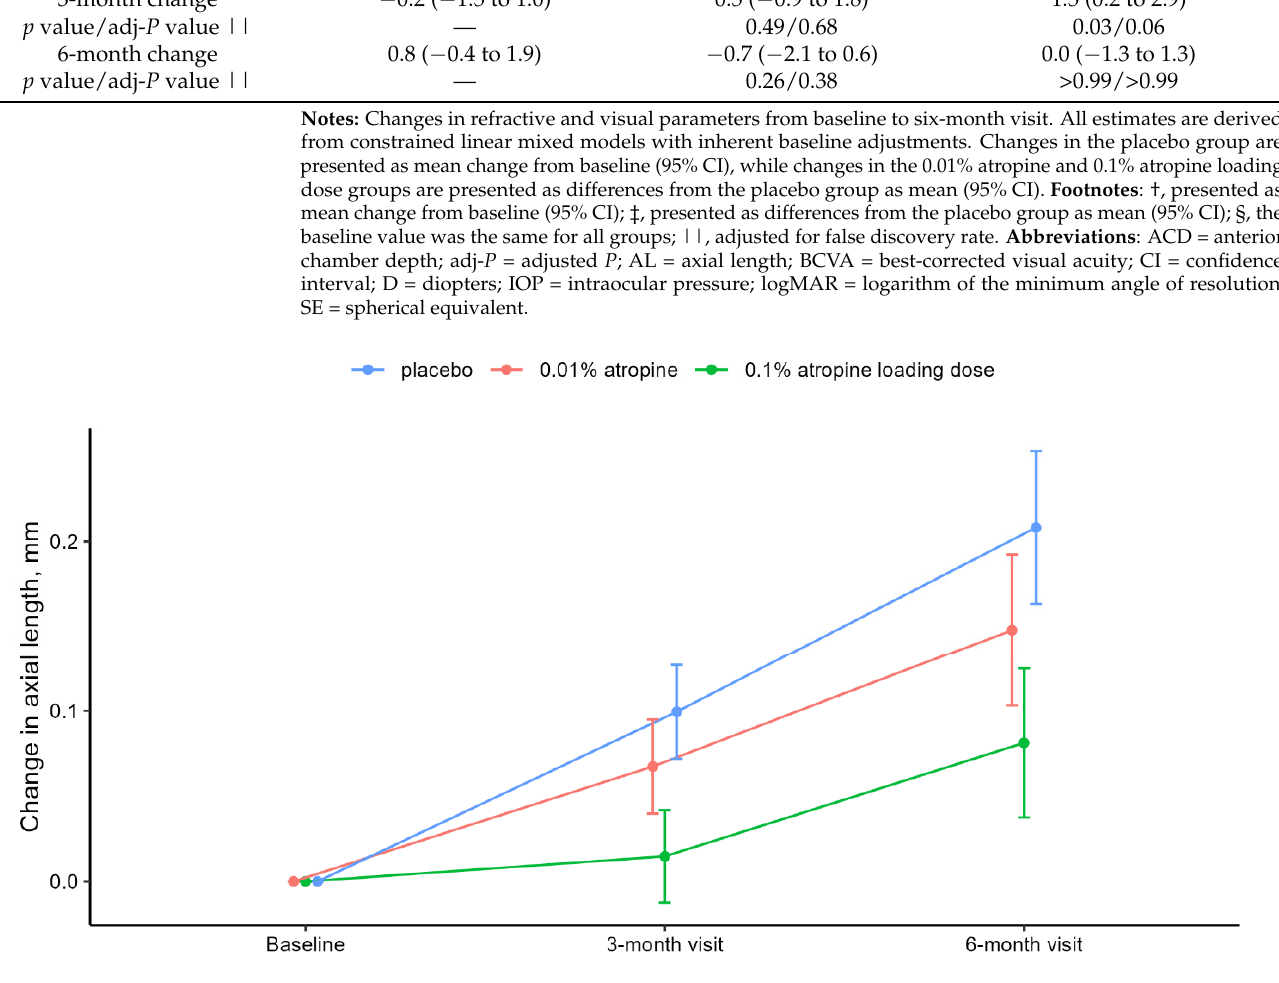
Figure 2. Change in AL from baseline. Notes: Mean change in axial length from baseline to six-month visit with placebo (blue), 0.01% atropine (red), and 0.1% atropine loading dose (green). Error bars denote the 95% CIs of the mean changes. Means and CIs are derived from the constrained linear mixed model with inherent baseline adjustment. P and adj- P values are presented in Table 2. Abbreviations: adj- P = adjusted P ; CI = confidence interval.